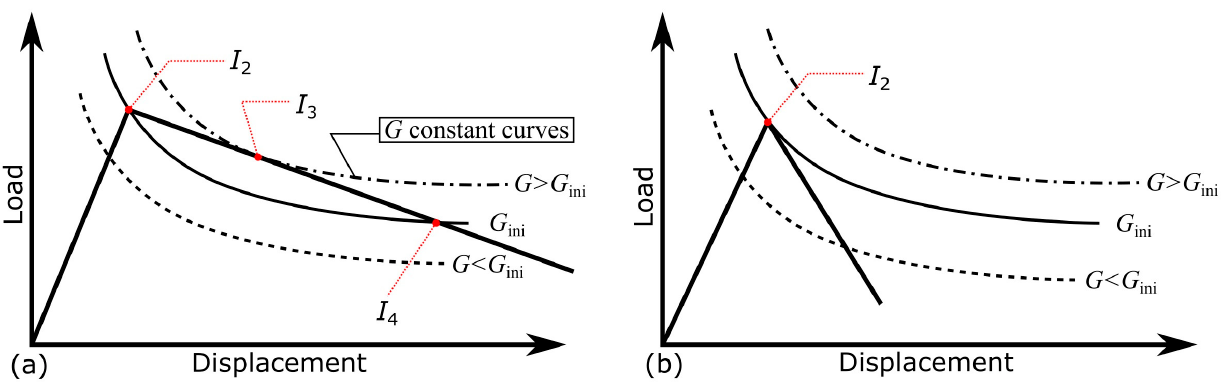
Figure 6. Schematic diagram of the relationship between the experimentally determined load–dis- placement relationship and energy release rate constant curve in the case for ( a ) a small spring con- stant and ( b ) a large spring constant.